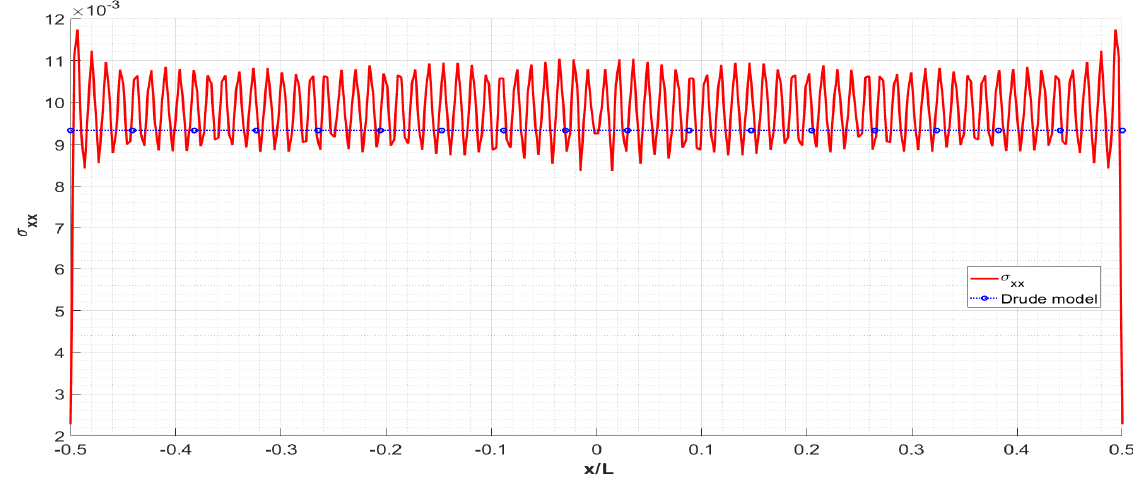
G Ll . L = 800 nm, μ = 0.1 Drude